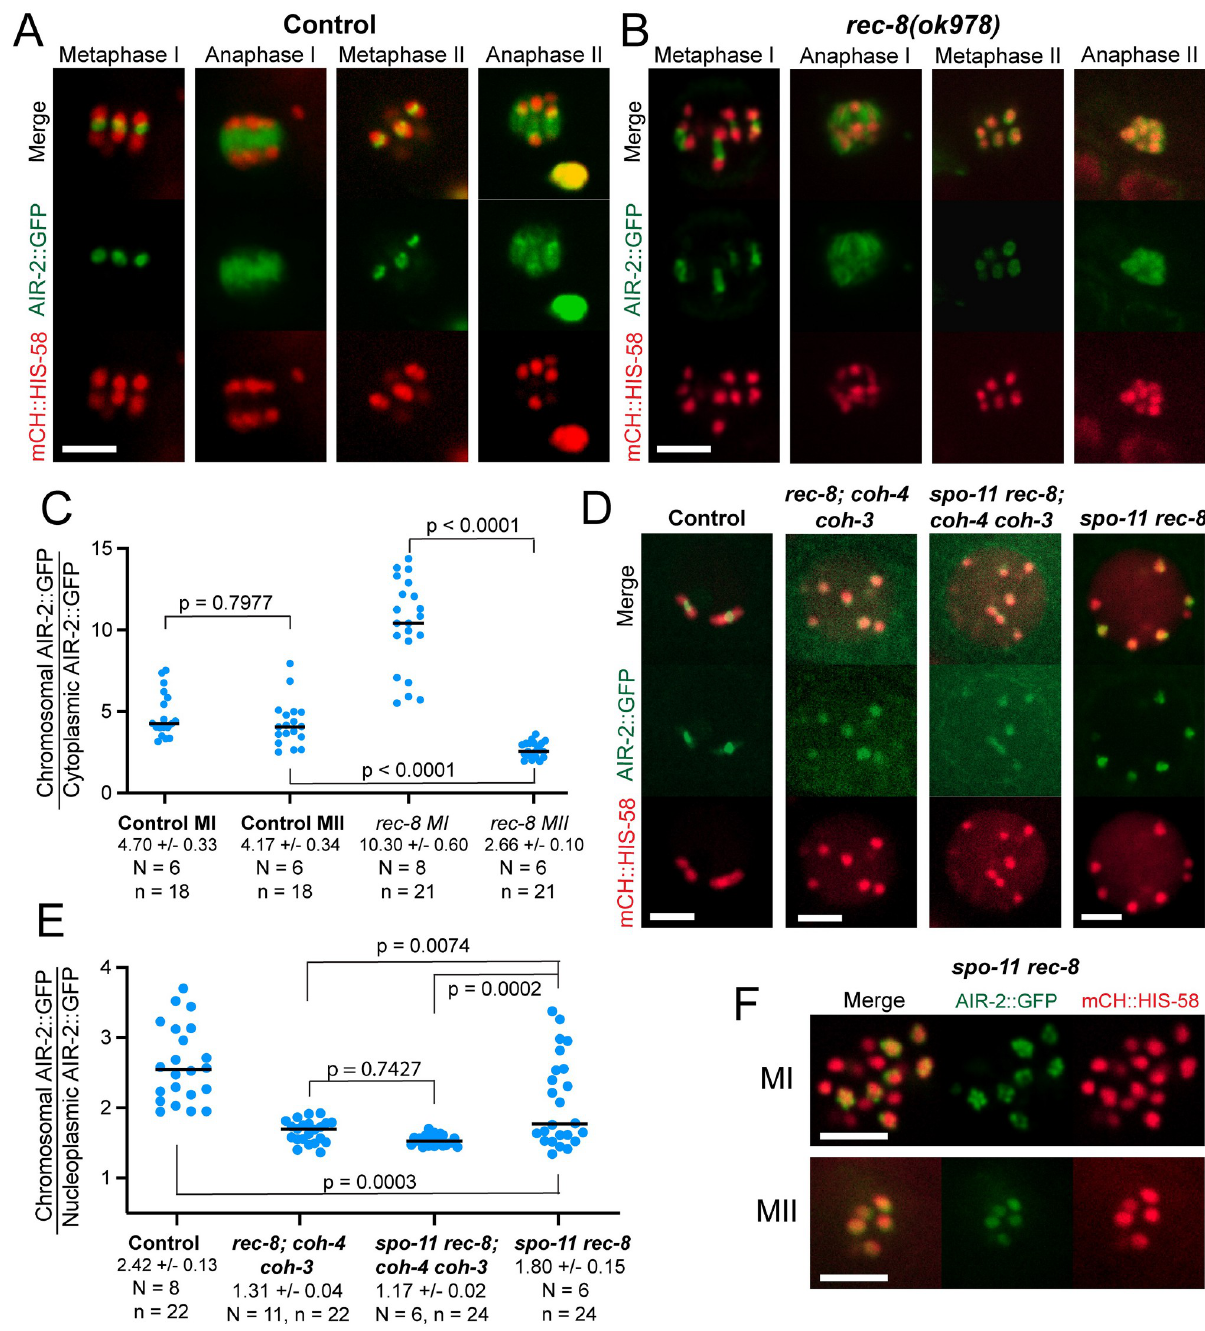
Fig 5. AIR-2::GFP levels are diminished and diffuse in the absence of cohesin. (A) In time-lapse images of control embryos, AIR-2::GFP is in the midbivalent ring structure during metaphase I and II and on MTs during anaphase I and II. (B) In rec-8(ok978) , AIR-2::GFP is an expanded ring structure during MI, diffuse on chromatids in MII and extends into a broader area during both anaphase I and II, consistent with transfer to microtubules. (C) Quantification of AIR-2::GFP intensities on chromosomes relative to the cytoplasm in control and rec-8(ok978) . Ratios varied depending on the distance of the chromosomes from the coverslip. N, number of embryos. n, number of chromosomes. The higher than control intensities in rec-8 MI might be due to the previously reported [23] expanded ring structure between chromatids which might involve unresolved synaptonemal complex intermediates [25,27].(D) -1 oocyte nuclei in living control and mutant worms expressing AIR-2::GFP and mCH::HIS-58. (E) Quantification of AIR-2::GFP intensities on chromosomes relative to the nucleoplasm in control and mutant oocytes. N, number of oocytes. n, number of chromosomes. (F) MI and MII metaphase chromosomes in living spo-11(me44) rec-8(ok978) embryos. All bars = 4 μ m.